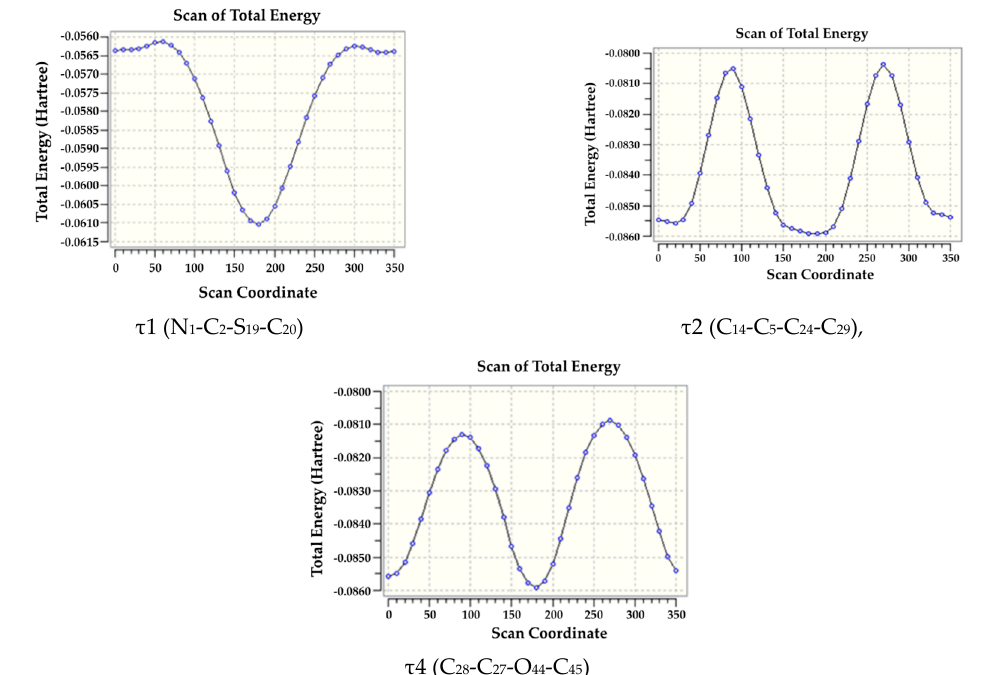
Figure 4. One-dimensional potential energy surface (PES) scan of the calculated energies vs. dihedral angles ( τ ) using DFT/B3LYP/6-31G(d,p) for 5-(4-methoxyphenyl)-2-methylthio-5,12-dihydrobenzo[ g ]pyrimido[4,5- b ]quinoline-4,6,11(3 H )-trione 4c . Structure of highest and lowest energy conformers for τ 1, τ 2 and τ 4 dihedral angles and the